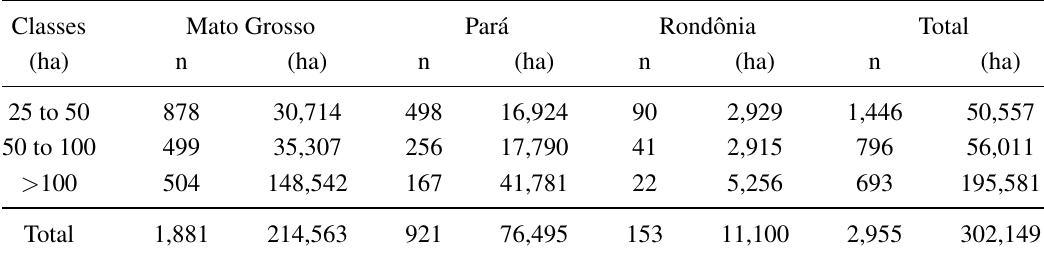
Table 4. Number of polygons (n) and deforested area (ha) monitored in the states of Mato Grosso, Par´a and Rondˆonia during the 2009/10 crop year.